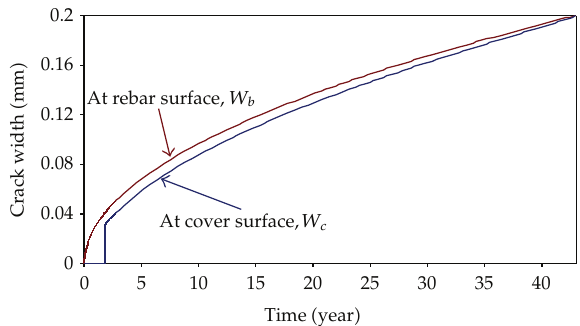
Figure 5: Crack widths at rebar surface (cid:5) w b (cid:6) and at cover surface (cid:5) w c (cid:6) with time t